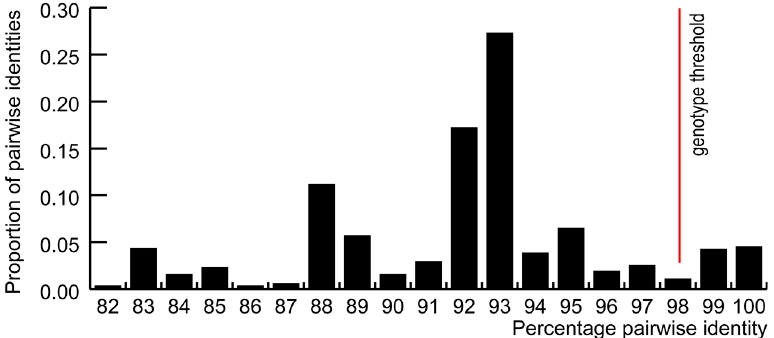
Figure 1. Distribution of pairwise identities of the 63 GoCV genomes. For the purpose of this study, a 98% pairwise identity was used as genotype threshold.